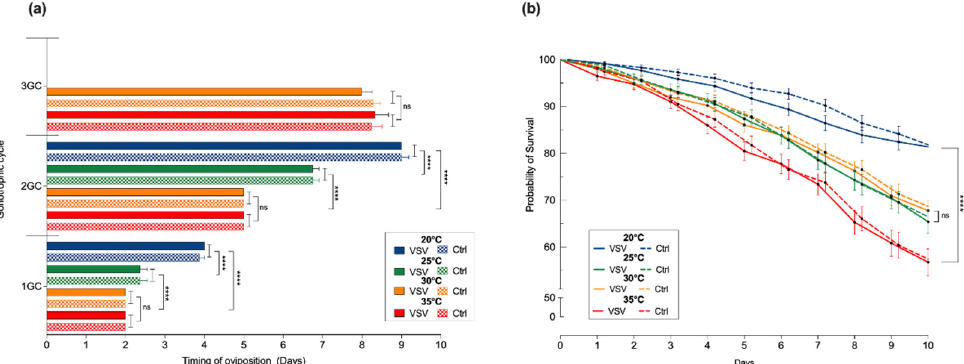
Figure 2. Constant temperature-mediated effects on ( a ) the gonotrophic cycle (GC) and ( b ) the survival of VSV-fed and non-infected control midges held at constant temperatures of 20 °C (blue), 25 °C (green), 30 °C (orange), and 35 °C (red). Two-way ANOVA with multiple comparisons was used to determine statistical significance in the timing of oviposition, as indicated ( p > 0.05, ns, not significant; **** p ≤ 0.0001). Survival curves were calculated using the Kaplan–Meier method. Error bars represent the standard error of the mean (SEM).